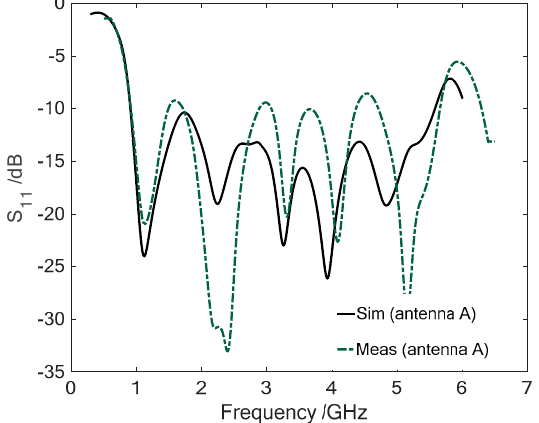
Figure 9. Reflection coefficients of the proposed antenna A, comparing the measured result with the simulation.